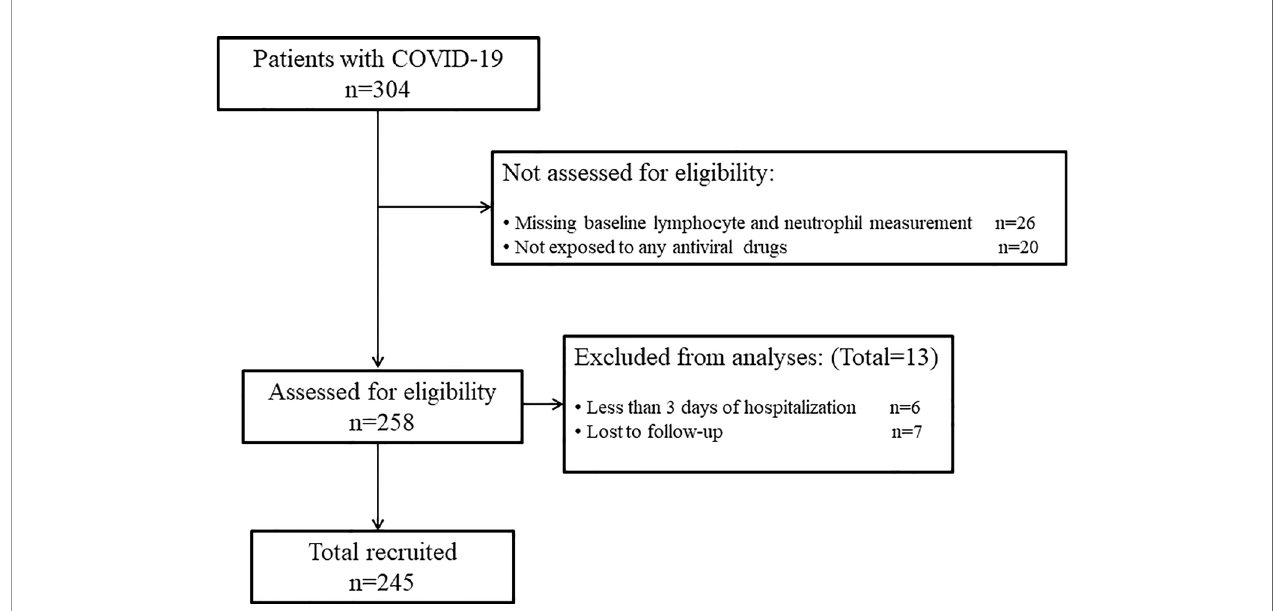
FIGURE 1 | Flowchart of the included COVID-19